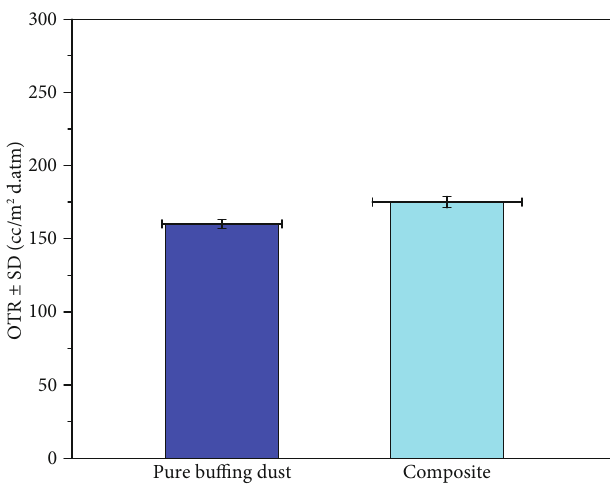
Figure 3: Oxygen gas transmittance rates (OTR) of pure bu ffi ng dust and composite fi lm.